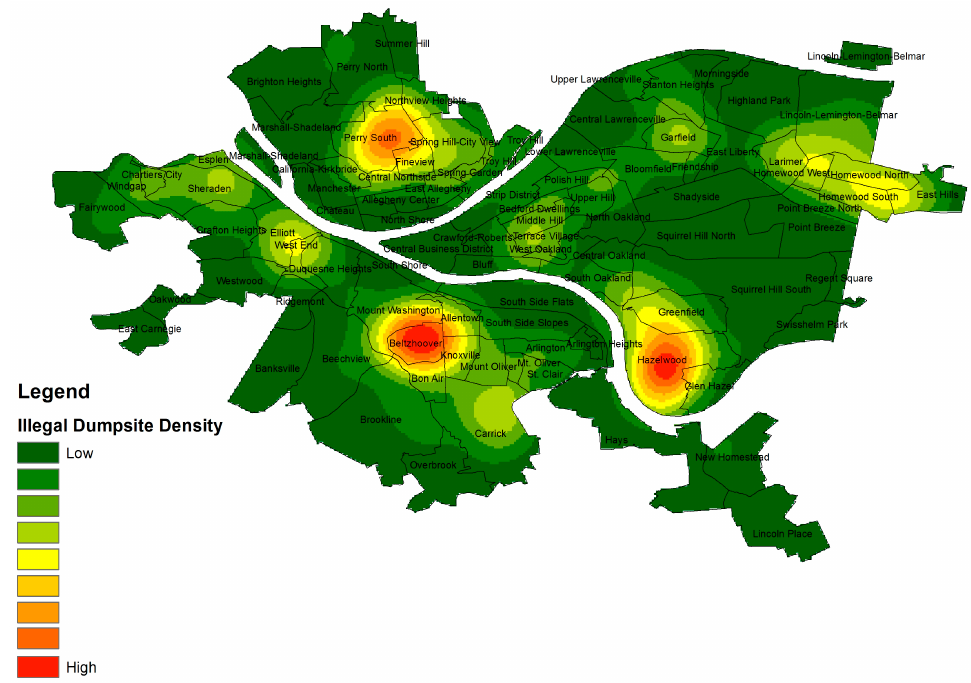
Figure 2. Heat map of illegal dumpsites across the city of Pittsburgh.